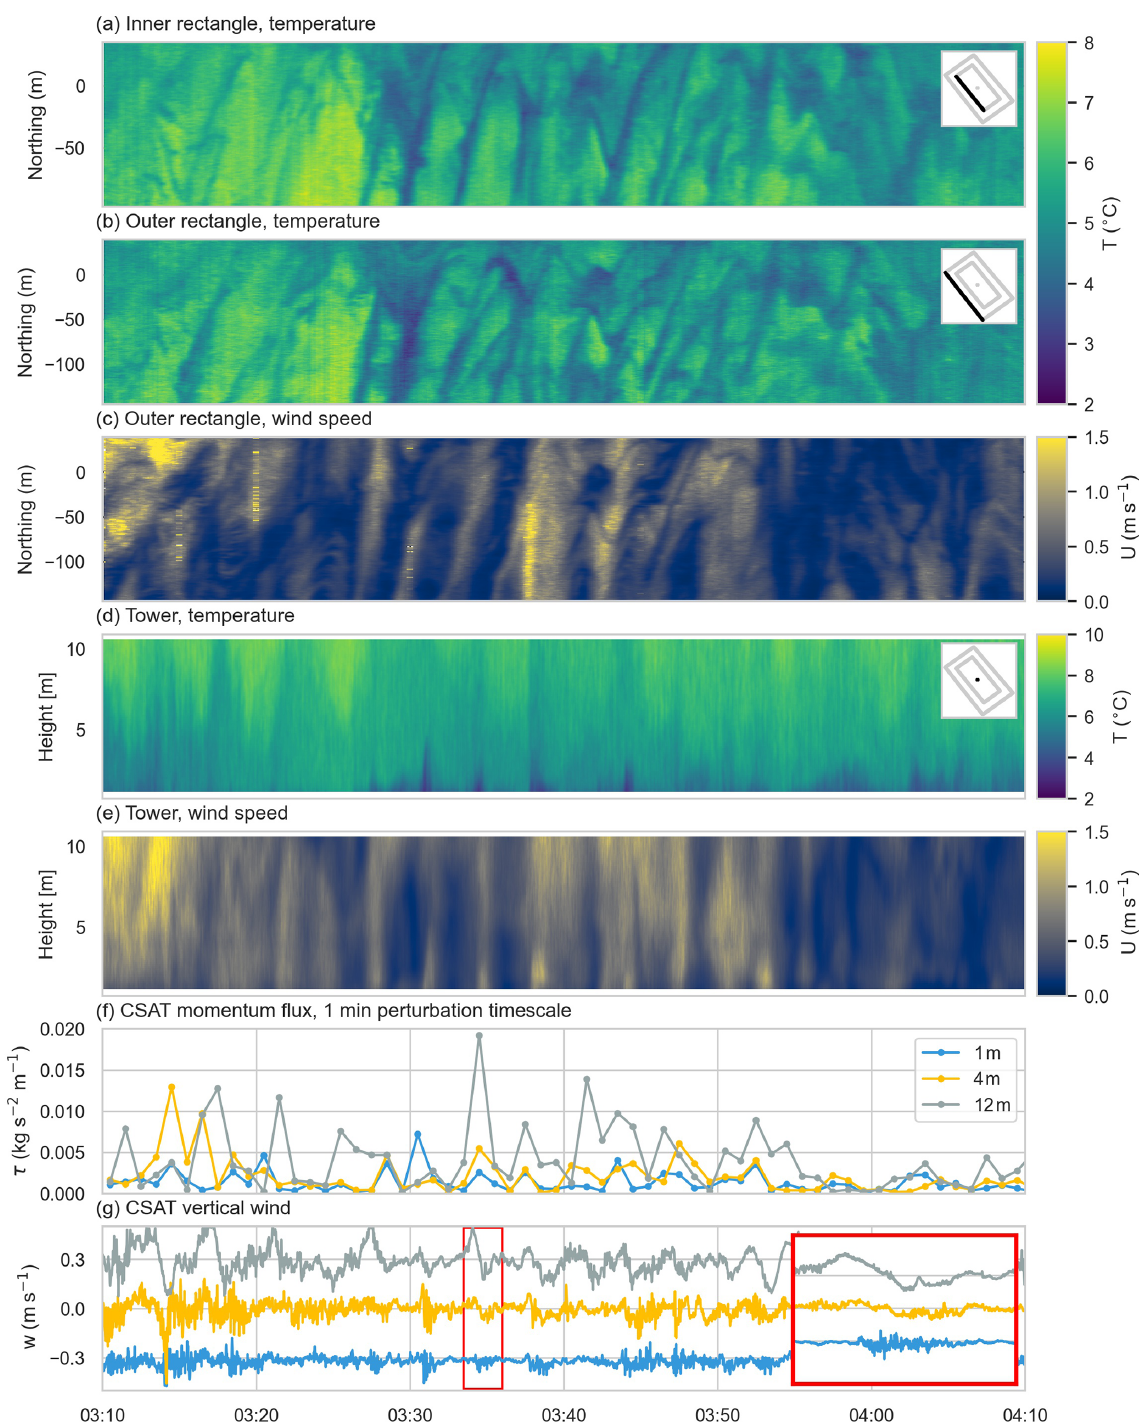
Figure 10. The tower and surface DTS array for a subset period of Fig. 9. The (a) inner and (b) outer rectangle temperature and (c) wind speed indicate similar wave structures propagating horizontally across the surface. Vertically, the (d) FODS tower temperature and (e) wind speed capture the vertical cross-section of these waves. (f) CSAT observations of the momentum flux calculated using a 1min perturbation. (g) CSAT vertical wind speed at 20Hz suggests that these waves became distorted by near-surface stability, thereby generating turbulence. A subset (red rectangle) of the vertical wind speed in (g) is highlighted in the inset axes. The mean vertical wind speed is offset by 0.3ms − 1 for each vertical level for clarity. Times indicated in the figures are in CET.